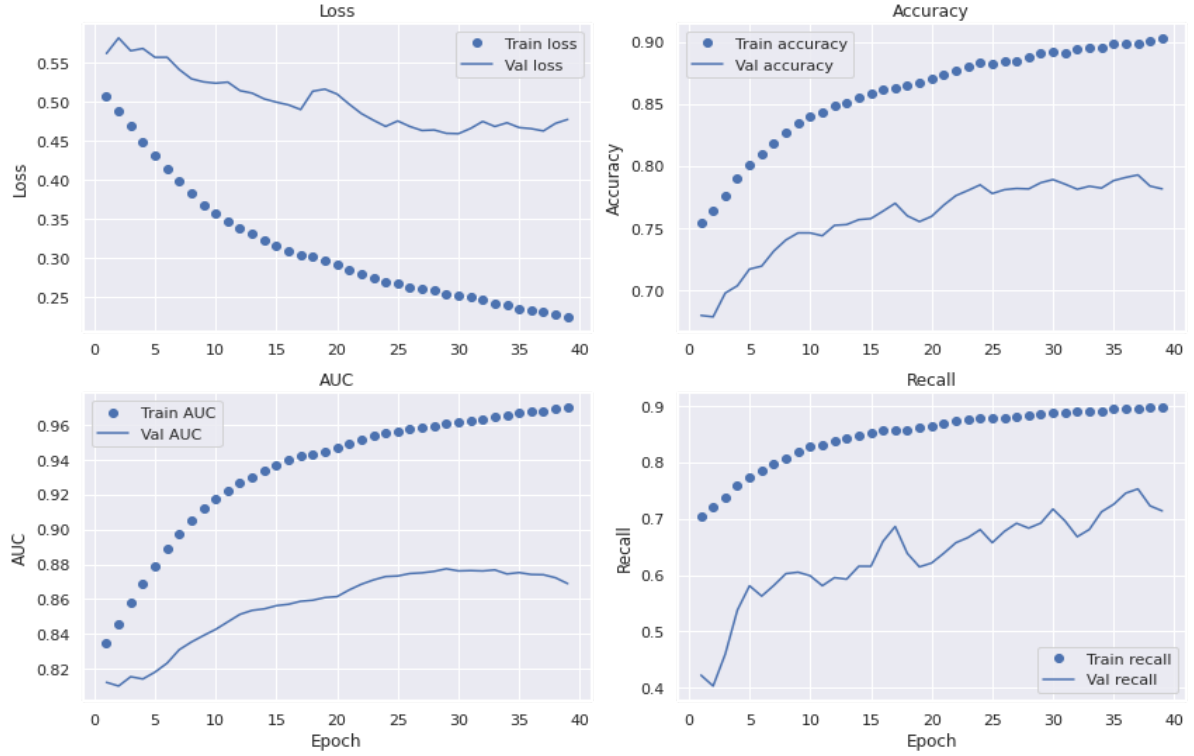
Figure 10. An example of progress improvements in a training and validation data set in terms of accuracy, AUC, and recall by the improved ShuffleNet learning.